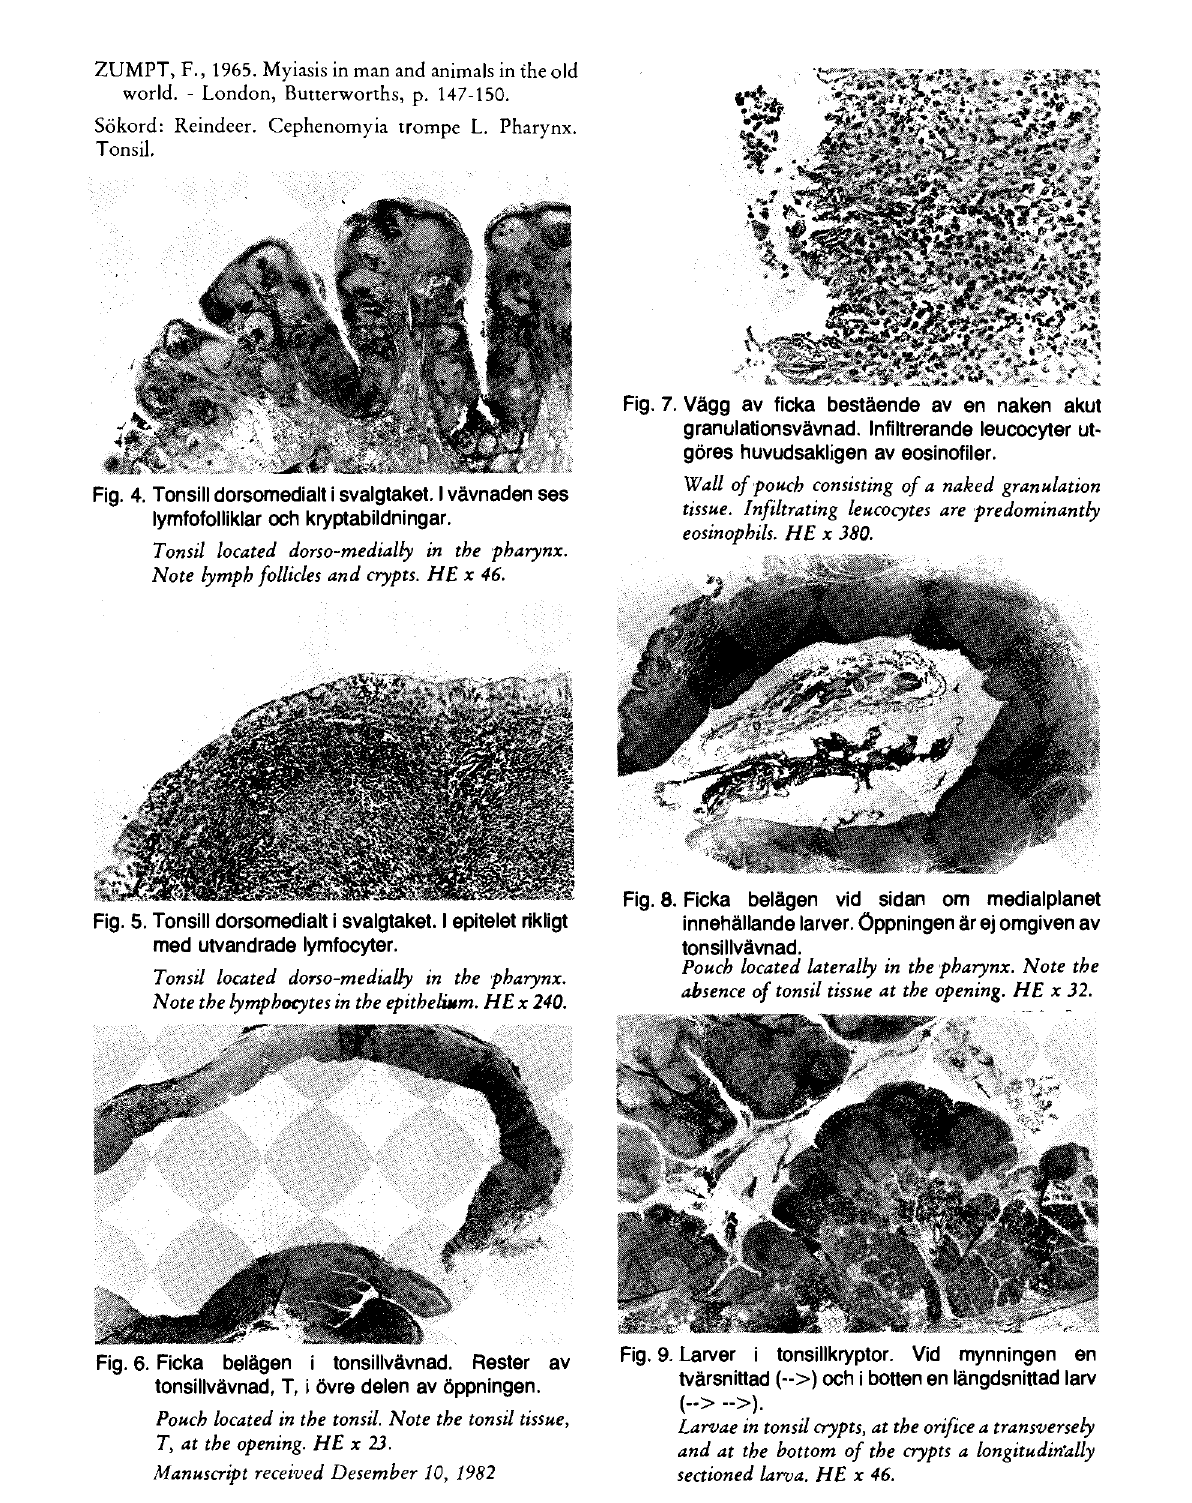
Fig. 6. Ficka belägen i tonsillvävnad. Rester av tonsillvävnad, T, i övre delen av öppningen. Pouch located in the tonsil. Note the tonsil tissue, T, at the opening. HE x 23.